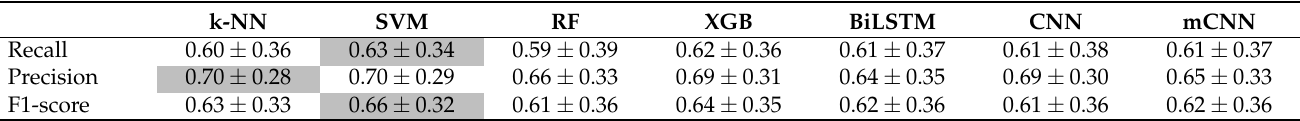
Table 2. This table shows the recall, precision, and F1-score of the leave-one-subject-out cross-validation, averaged across all twelve labels, with the corresponding standard deviations. The best results are shown as gray cells. The term “mCNN” is an abbreviation for “multi-resolution CNN”.